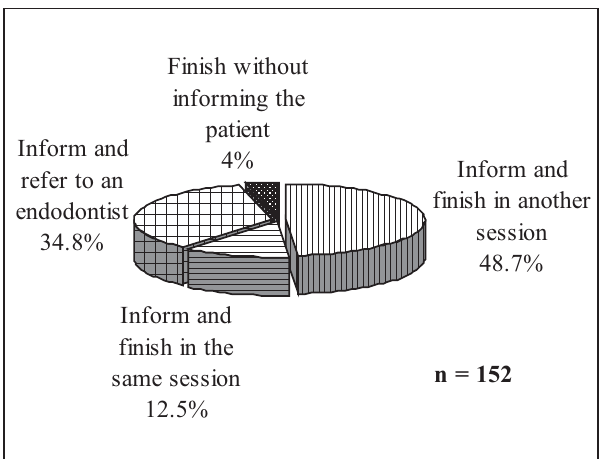
Fig. 2 - Conduct of general dentists in case of impossibility of removing the instrument fragment from the root